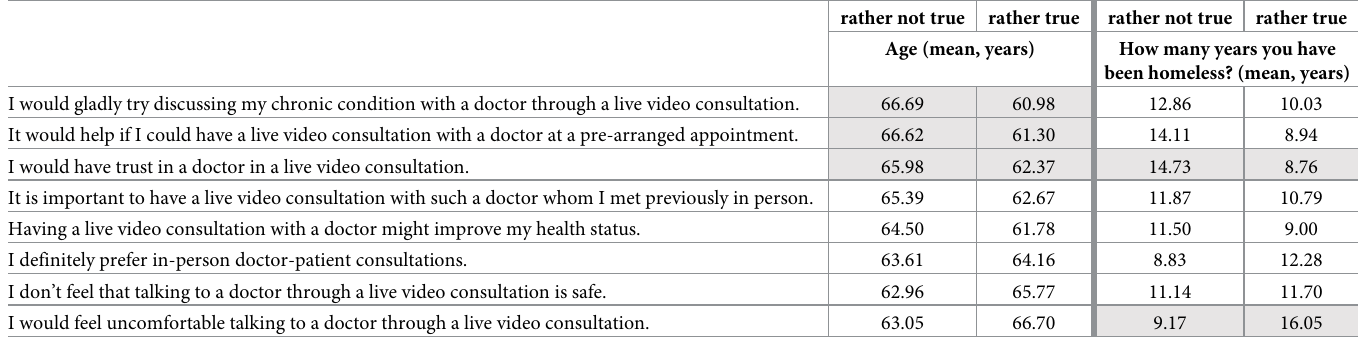
Table 4. Association between age, years of homelessness and telecare attitude within the group of homeless